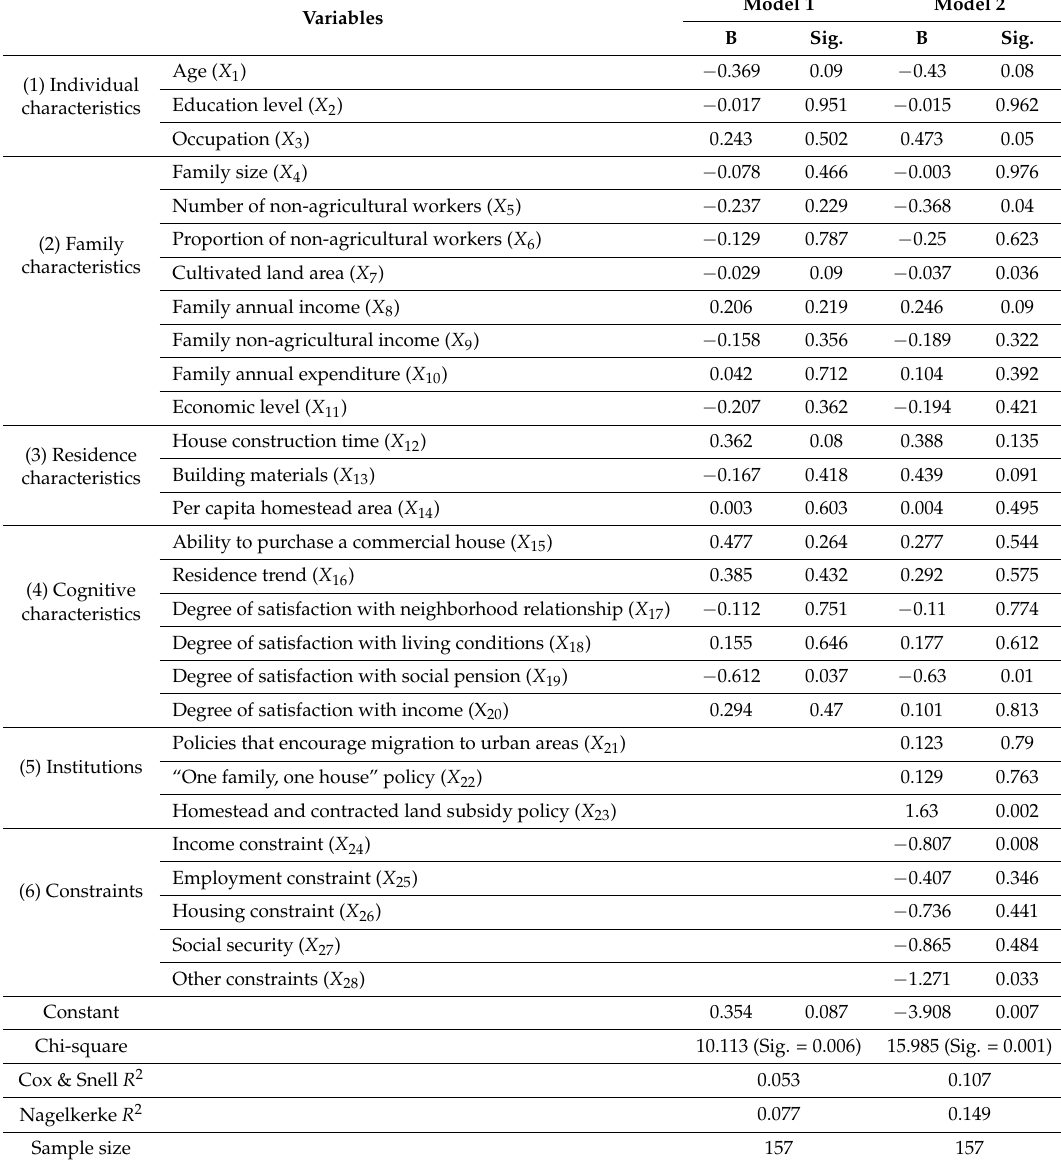
Table 3. Logistic regression analysis results of factors influencing farmers’ willingness to migrate to urban